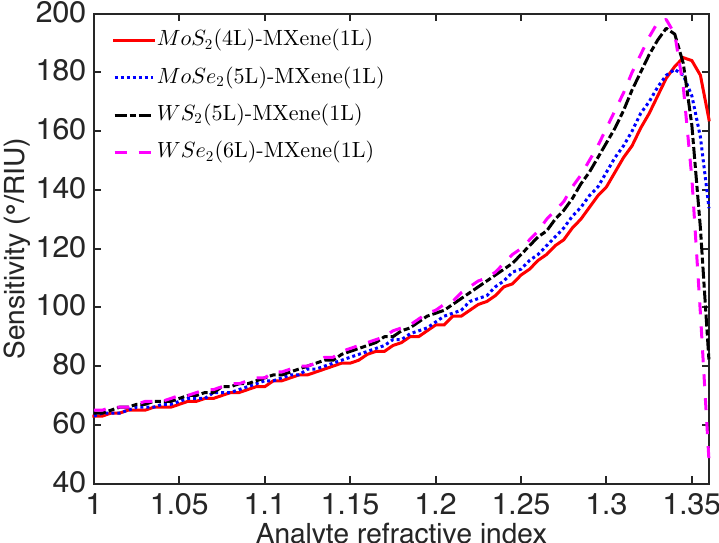
Figure 5. Variation of sensitivity for the optimized Ti 3 C 2 T x -TMD-based SPR sensor with the varying analyte